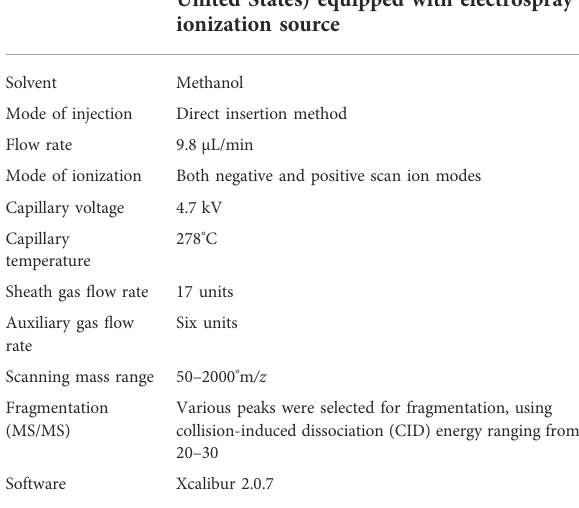
TABLE 2 General conditions for sample analysis by MS/MS.